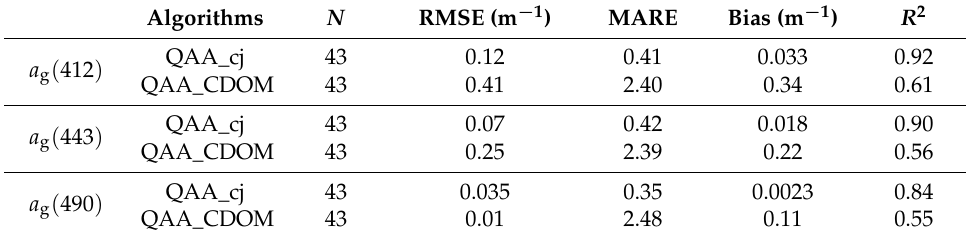
Table 5. Comparison statistics between the QAA_cj and QAA_v6 algorithms based on in situ dataset collected from Changjiang estuarine and its adjacent coastal waters ( N is the number of validation data).